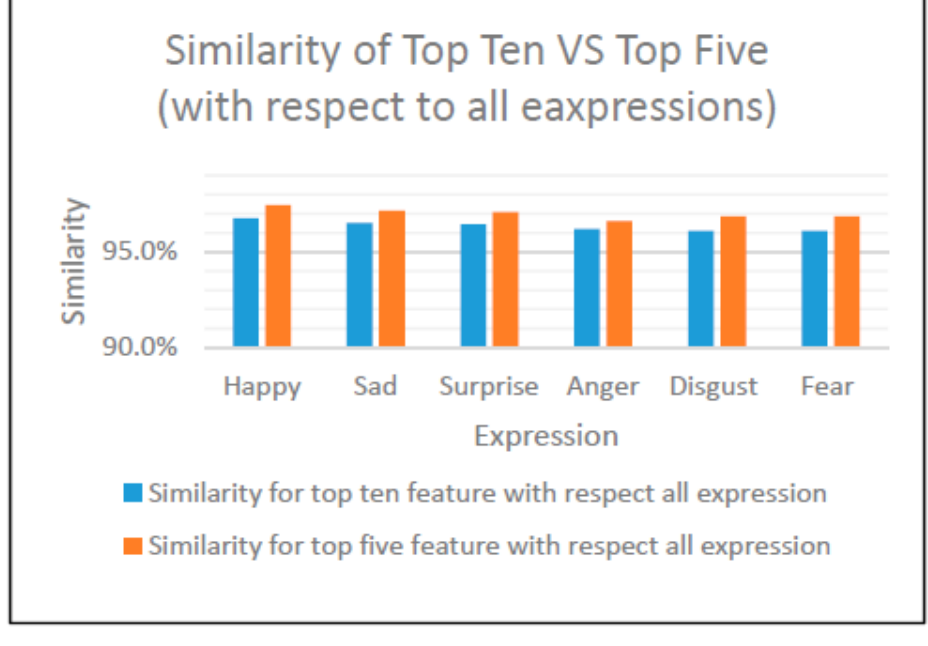
Figure 27. Top ten vs. top five features.